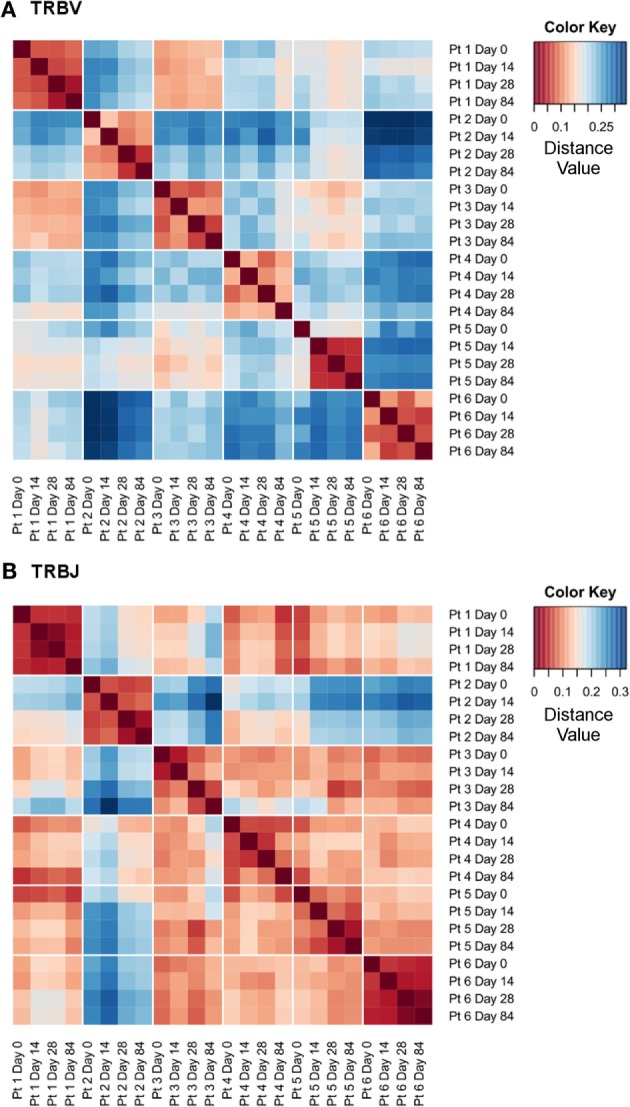
High intra-individual similarity in TRBV and TRBJ gene segment usage. Distance heatmaps using Manhattan distance measures for TRBV
(A) and TRBJ
(B) gene segment usage calculated from the gene segment frequency following the primer trimming step.